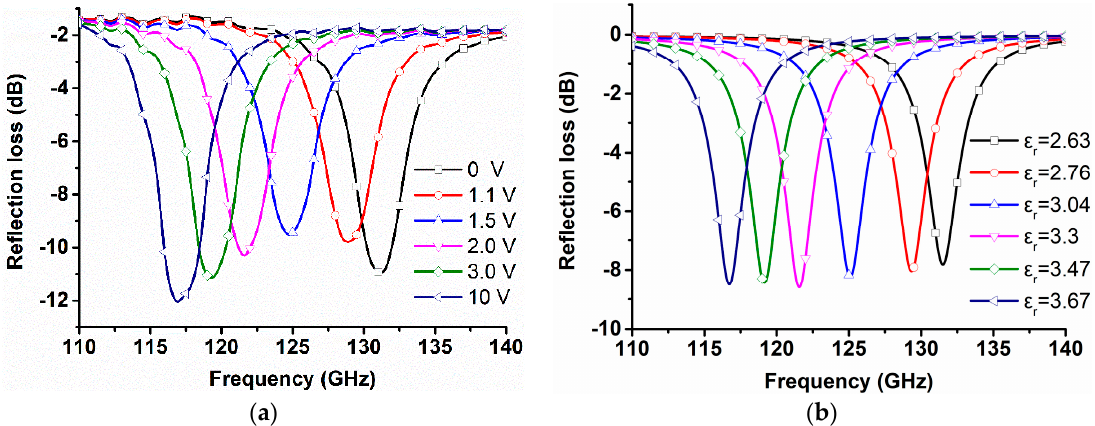
Figure 8. ( a ) Measured reflection amplitude of the liquid crystal based phase shifter; ( b ) simulated reflection amplitude of the liquid crystal based phase shifter.